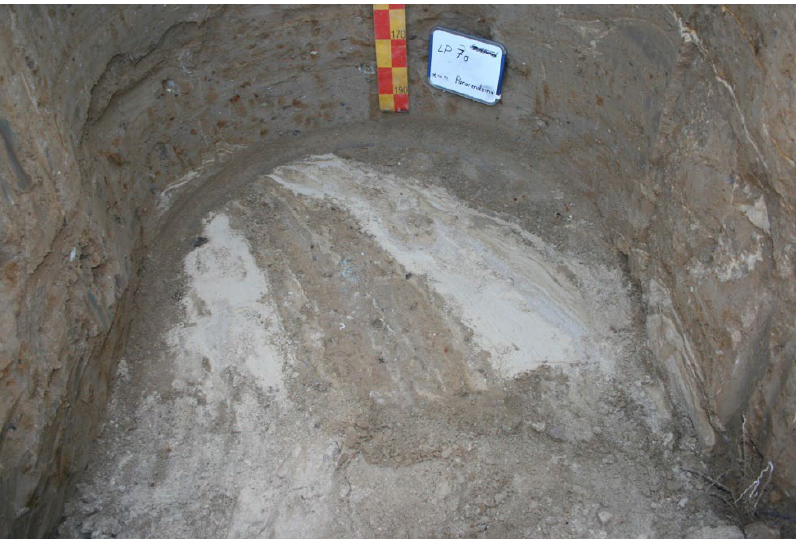
Figure A4. Sand bands providing a preferential flow pathway for the tracer movement in the Reg- osol.